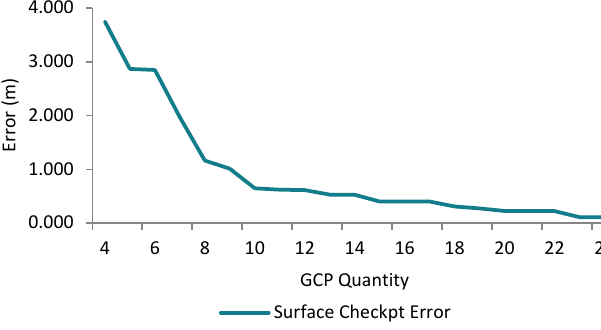
Figure 11. Surface checkpoint error plotted with respect to the GCP Quantity